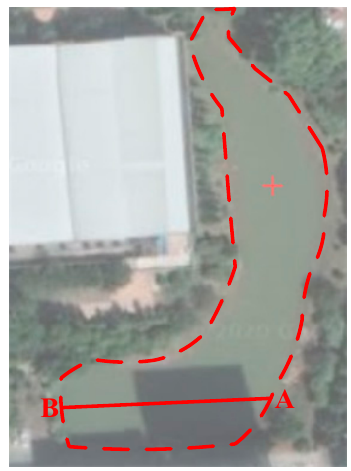
Figure 20. Diagram of the experiment site.